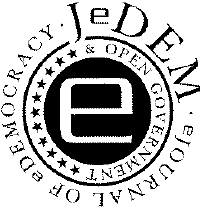
Table 1: Scholarly Definitions of Open Government